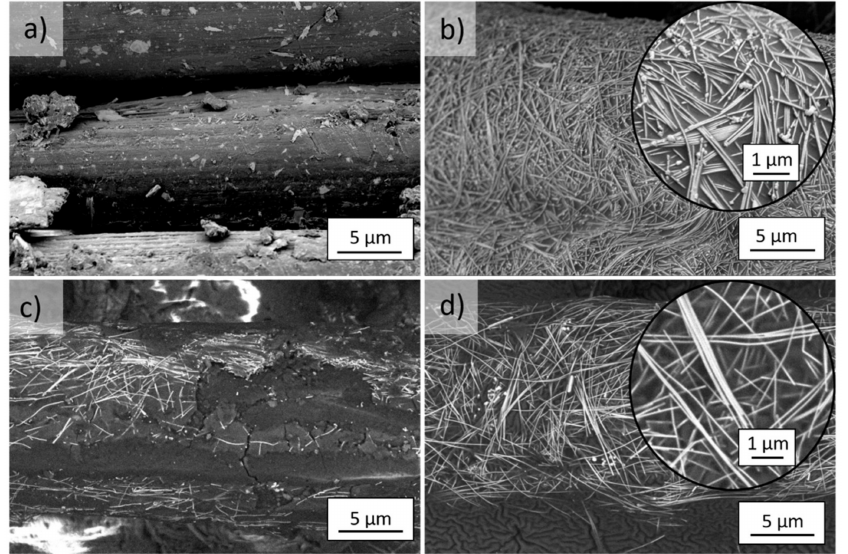
Figure 7. SEM images of UV irradiated (365 nm, 96 h) m Ar fibers ( a ) reference and after ( b ) 5-fold AgNWs application, ( c ) mixture Ag+S and ( d ) layer by layer Ag/S modification (magnification of 6500 × and 20,000 ×